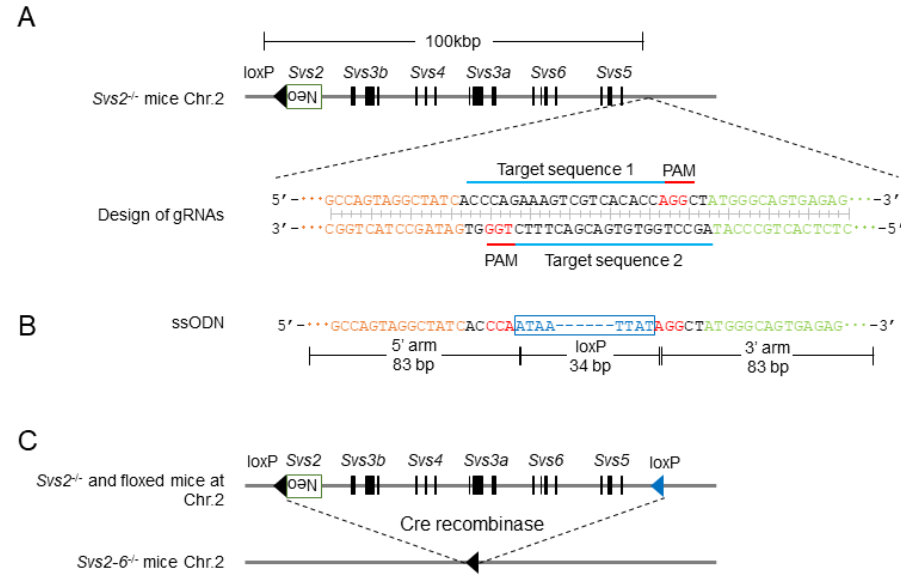
Figure 2. Genome editing strategy for knockin mice carrying a loxP cassette and knockout mice lacking five Svs genes. ( A ) Schematic representation of the Cas9-gRNA targeting sites. Two types of gRNAs were designed downstream of Svs5 . Blue lines label the CRISPR target sequence. Red characters indicate protospacer adjacent motif (PAM) sequences. Orange and green characters indicate the upstream and the downstream region of the targeting site, respectively. ( B ) ssODN sequence for generating knockin mice. Knockin ssODN containing a loxP cassette and two 83 bp homology sequences. Blue characters indicate loxP sequence. Orange and green characters indicate homology arm with 5’ and 3’ of gRNA targeting sequence, respectively. ( C ) Generation of mice lacking Svs2–6 (almost 100 kbp) by a cre-recombination system.